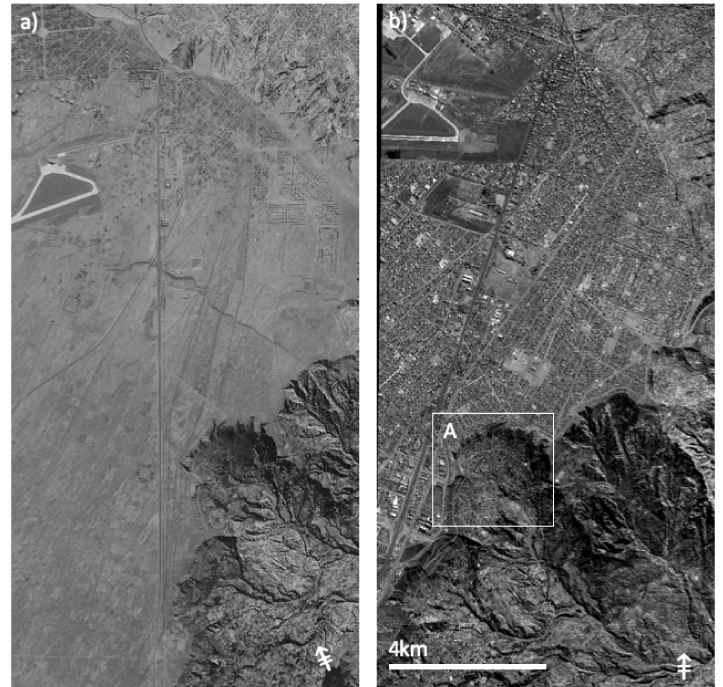
Figure 1. El Alto / La Paz, Bolivia. Area east of the airport in ( a ) 1967 and ( b ) 2004, showing urban growth on the plateau of El Alto, districts 1 and 2, towards the city of La Paz. White box A showing position of Figure 2. (Data, incl. coordinates: Table 3).